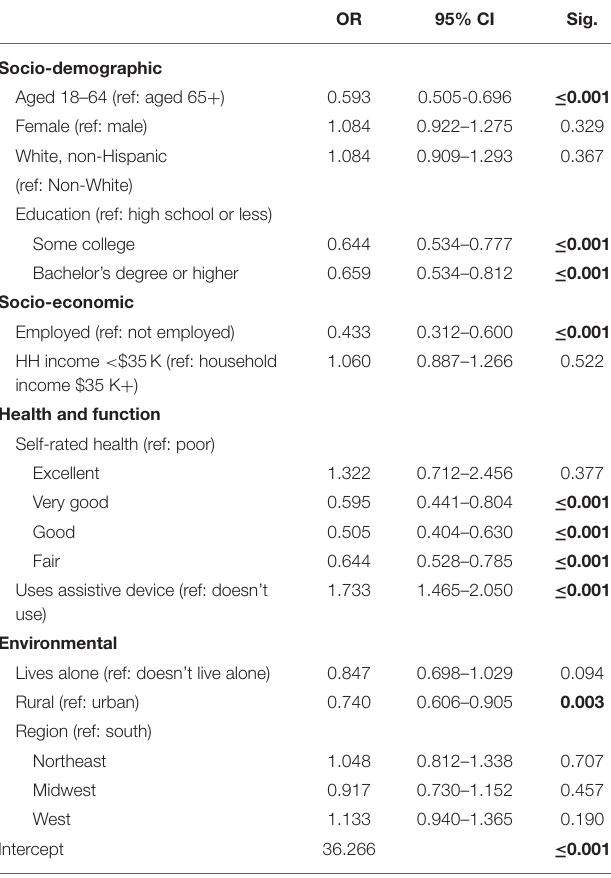
TABLE 4 | Logistic regression on odds of giving up driving (weighted). OR 95% CI